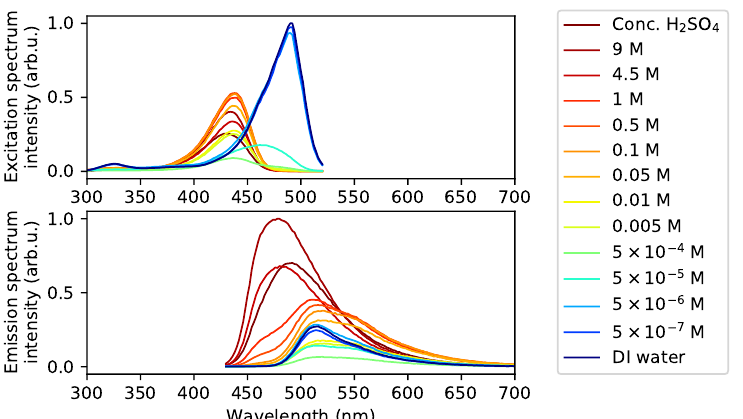
Figure 4. ( Top ) Fluorescein excitation spectra in H 2 SO 4 solutions (emission was integrated at 550 nm). ( Bottom ) Fluorescein emission spectra in H 2 SO 4 solutions (exciting wavelength was 400 nm).